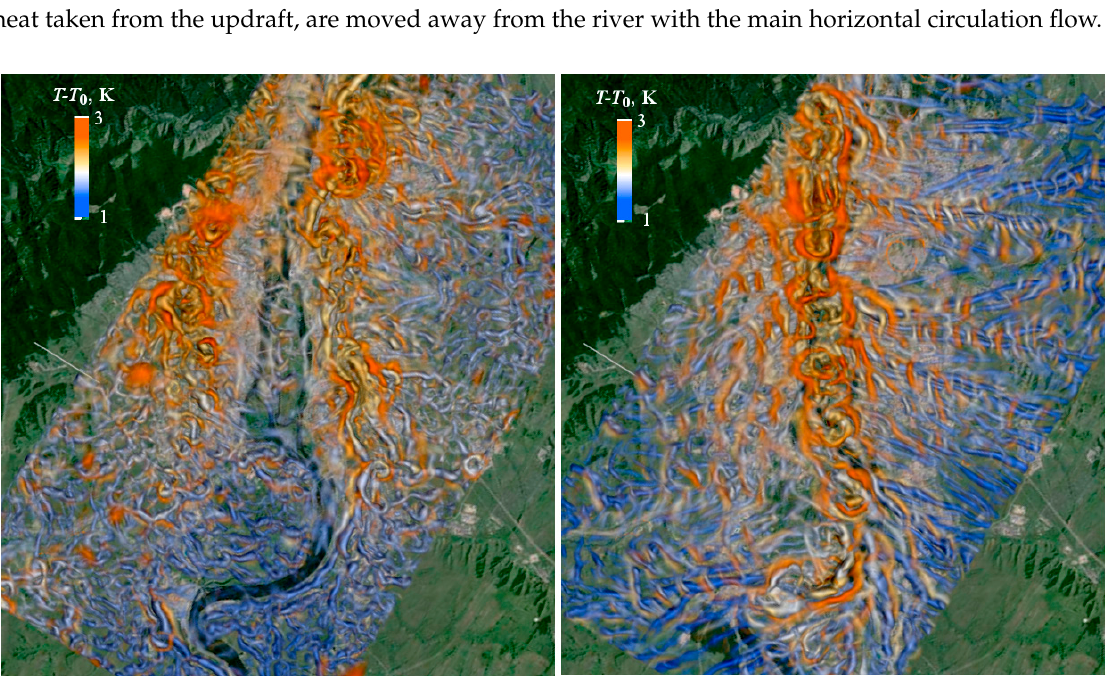
Figure 8. Instantaneous vortex structure over the city (1600 LT), visualized by the Q-criterion colored by the temperature. ( a ) Summer case; ( b ) Winter case.